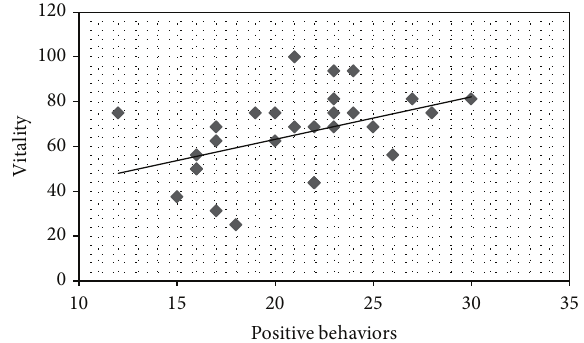
Figure 4: Correlation between vitality and positive behaviors. 𝑟 = 0.429 , 𝑃 = 0.020